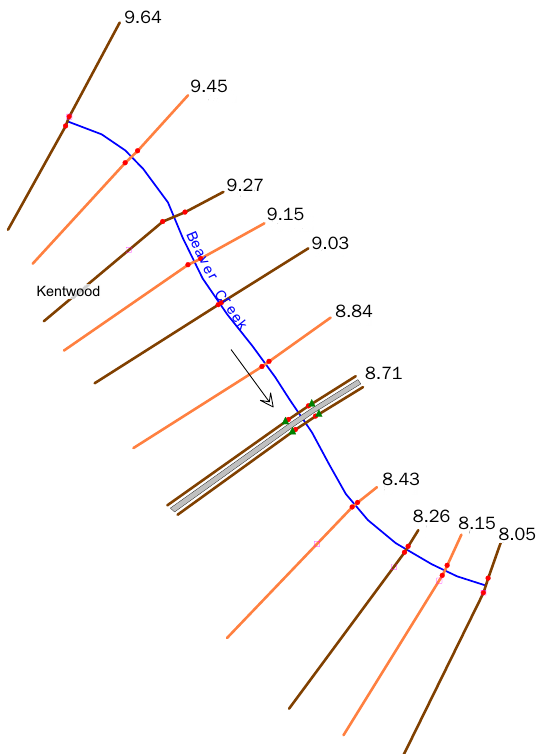
Figure 2. River and cross section geometries for Beaver Creek near Kentwood, Louisiana, in the FLODENCR model. The arrow indicates the direction of flow. A bridge structure is located at 8.69km.